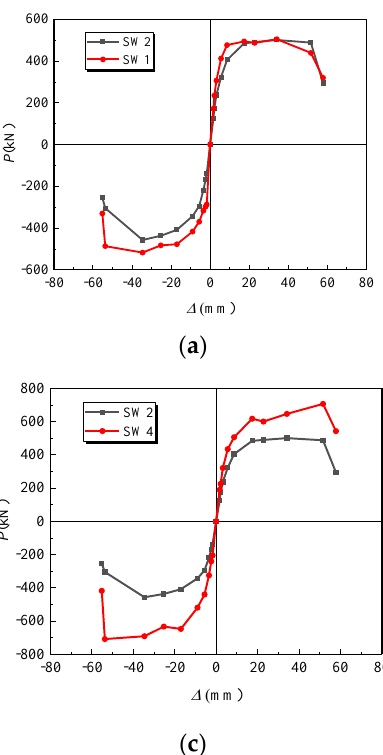
15 of 20 Figure 15. Hysteretic curves of specimen. ( a ) SW1; ( b ) SW2; ( c ) SW3; ( d ) SW4. 3.2.3. Horizontal Bearing Capacity (1) The horizontal bearing capacity of SW2 was equivalent to SW3. The horizontal bearing capacity of infilling DCLs and SCC composite shear walls were mainly related to the strength of longitudinal reinforcement in walls, the strength of concrete in steel tubes, and the strength of wall concrete. In addition, according to the calculation in reference [40], the reduction factors of the concrete strength in steel tubes were almost the same as those of the concrete strength in the walls of specimens SW2 and SW3. The results showed that the horizontal seismic bearing capacity of composite shear walls, filled with DCLs and SCC, and subjected to a standard fire on both sides for 1 h is not affected by spraying 20 mm fire-retardant coating on concealed column steel tubes; (2) Compared with SW2, the bearing capacity and energy dissipation capacity of SW4 were significantly improved. Therefore, appropriately increasing the width-thickness ra- tio has a significant impact on the seismic performance of specimens after a standard fire. 3.2.4. Skeleton Curve Figure 16 shows the effect of different parameters on the skeleton curves of shear walls. The important data for the skeleton curves of specimens are given in Table 4, where